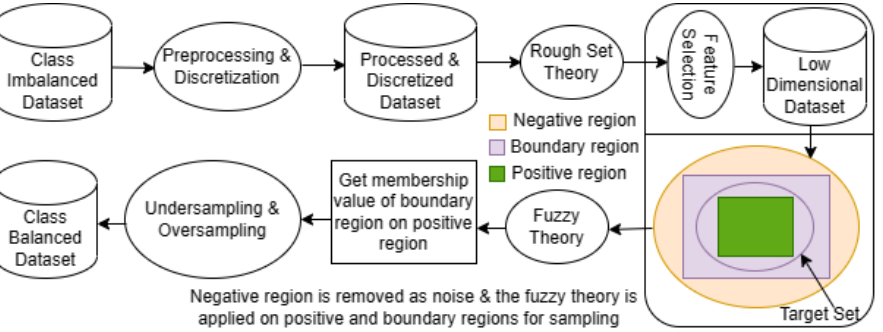
Figure 1. The WorkFlow of the proposed